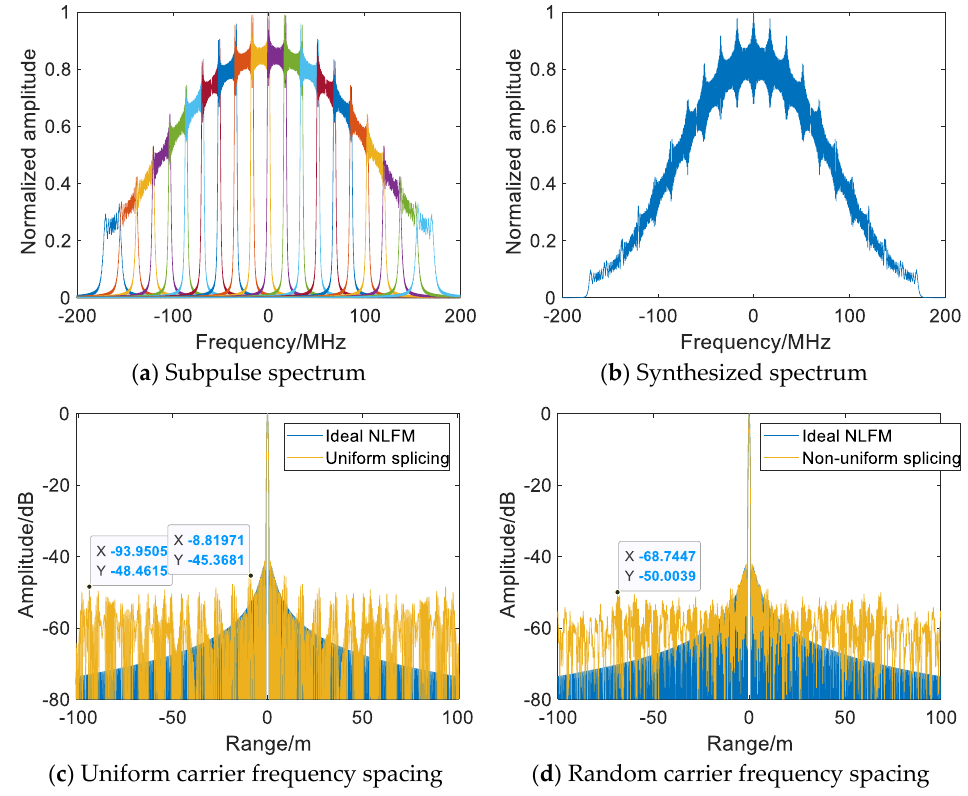
Figure 5. Range-compressed NLFM SWW ( 𝑁 = 20 𝐵 = 20.7 MHz 𝛥𝑓 = 17.2 MHz 𝑇 = 145 us ). Figure 6 demonstrates how the TxBW of each subpulse changes in the NLFM SWW.